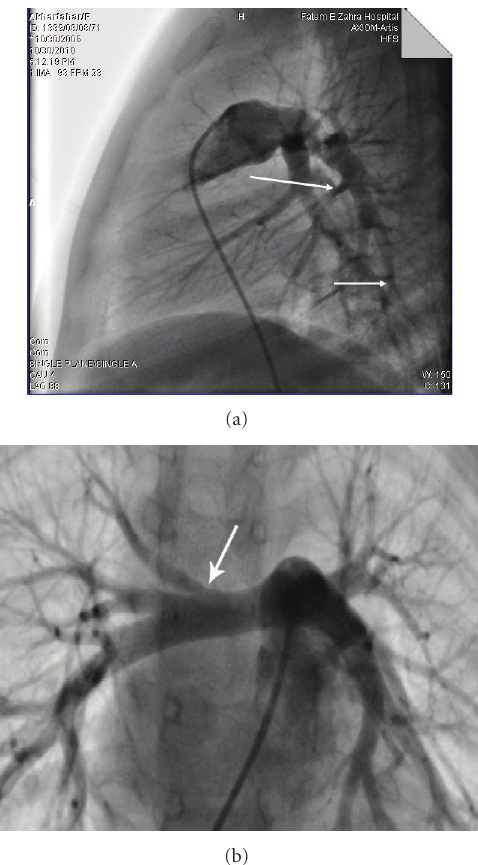
Figure 3: Angiography. Pulmonary artery injection: peripheral pulmonary